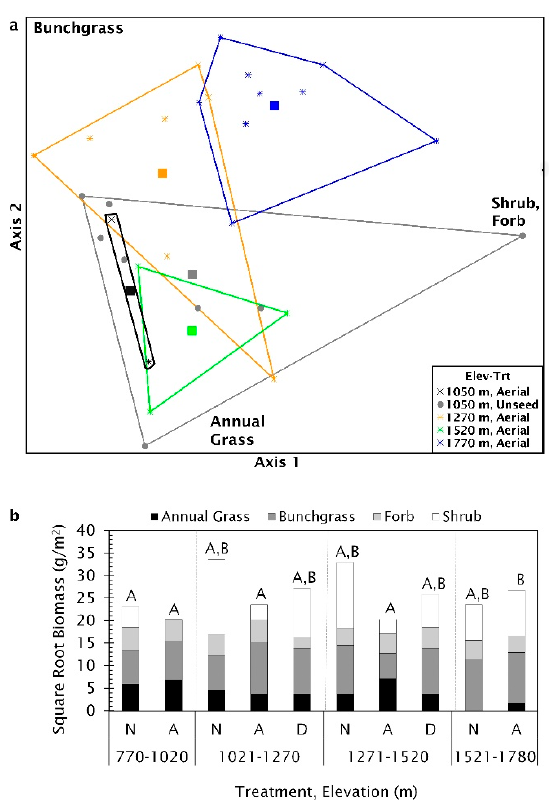
Figure 10. NMS ordination ( a ) illustrating significantly different plant community biomass composition for elevation and seeding treatment combination that was significantly different according to the multiple response permutation procedure ( α = 0.011). Plant functional groups labeled in ordination space indicate where the biomass for each group was the greatest (e.g., Shrub biomass increased from left to right on Axis 1 and from bottom to top on Axis 2). Mean biomass of each plant functional group ( b ) for each treatment (Aerial, A; Drill, D; Unseeded, N) along the elevation gradient: low (770–1020m), medium-low (1021–1270m), medium-high (1271–1520m), and high (1521–1780m). Letters represent differences in biomass amount and composition among plant communities. Drill seeded sites at low and high elevations had an n=1 and were dropped from the analysis.